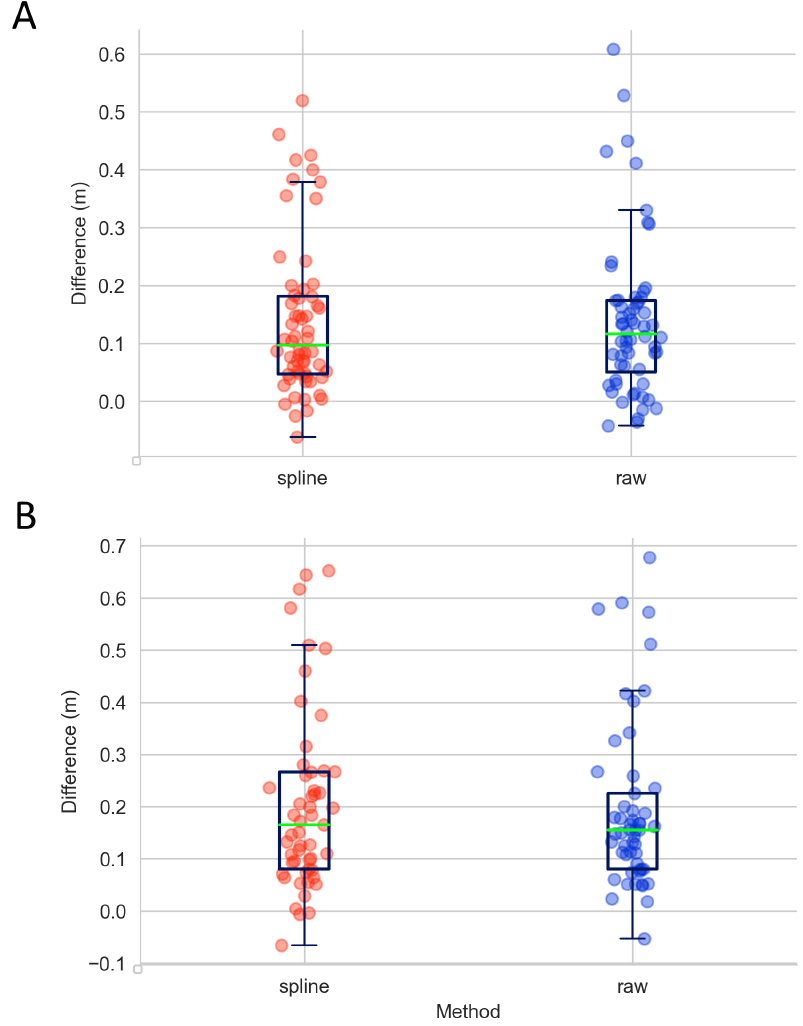
Figure 11. Two methods of computation of plant height (raw and spline) affect the distribution of the difference between LiDAR scanning and manual validation in ( A ) a 20 m AGL UAV flight and ( B ) a 40 m UAV